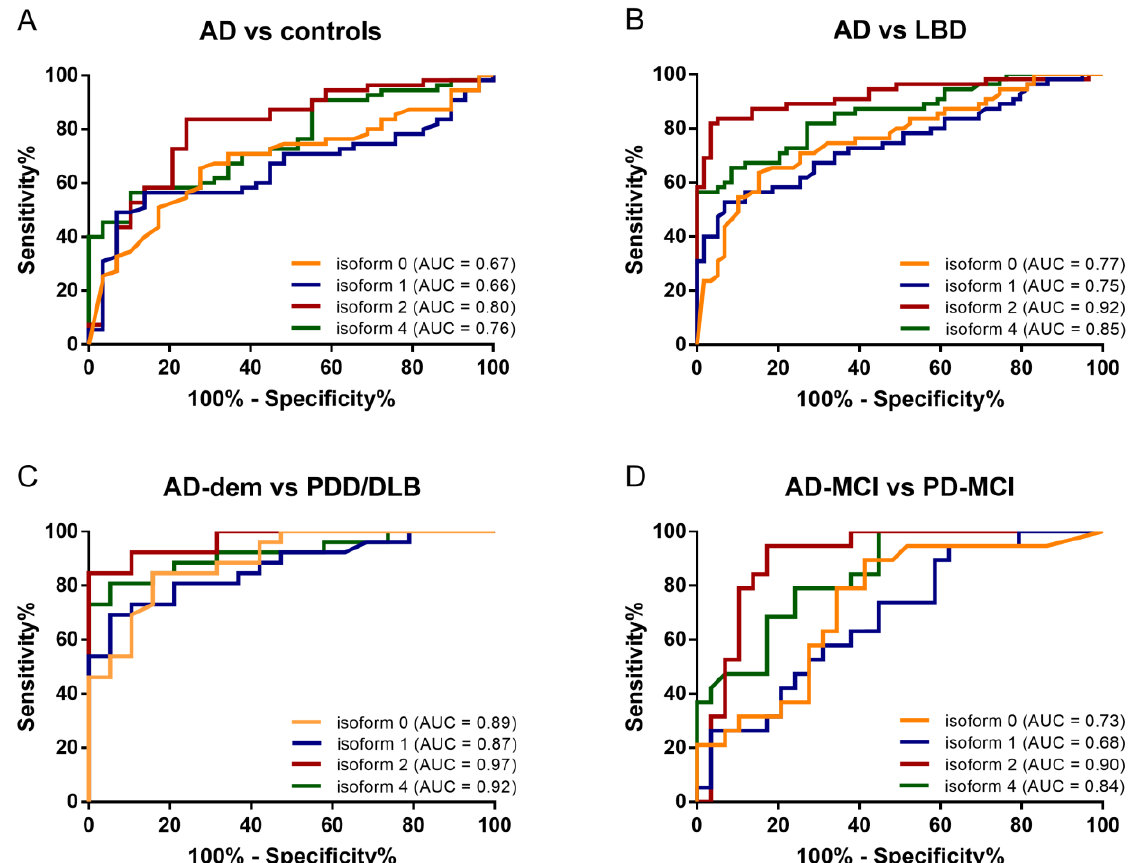
Figure 4. Receiver operating characteristic analysis. ROC curves relative to expression of isoforms 0, 1, 2 and 4 for discrimination of ( A ) AD vs. controls, ( B ) AD vs. LBD, ( C ) AD-dem vs. PDD/DLB and ( D ) AD-MCI vs. PD-MCI. Abbreviations. AD: Alzheimer’s disease; AD-dem: Alzheimer’s disease with dementia; AD-MCI: Alzheimer’s disease with mild cognitive impairment; AUC: area under the curve; DLB: dementia with Lewy bodies; LBD: Lewy body disease; PDD: Parkinson’s disease with dementia; PD-MCI: Parkinson’s disease with mild cognitive impairment; ROC: receiver operating characteristic.